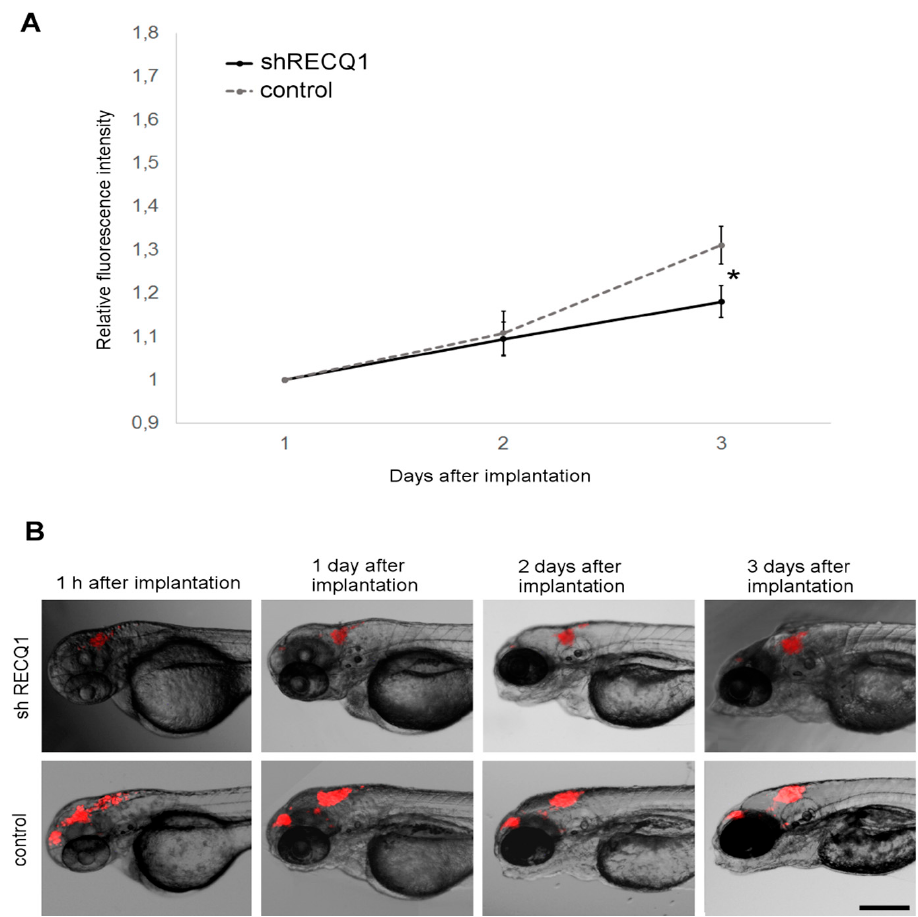
Figure 5. Xenotransplanted U87 DsRed cells in the brain of zebrafish embryos. ( A ) Changes in DsRed fluorescence of xenografts in the brain of zebrafish embryos between day 1 and day 3 after implantation. Averages ± SE are shown. The increase in fluorescence intensity of RECQ1-silenced cells was significantly smaller relative to control cells at day 3 after seeding; ( B ) Sequential images of xenotransplants in the brain of zebrafish embryos between 1 h and 3 days after implantation. Scale bar: 250 µm. Significance: * = p ≤ 0.05.